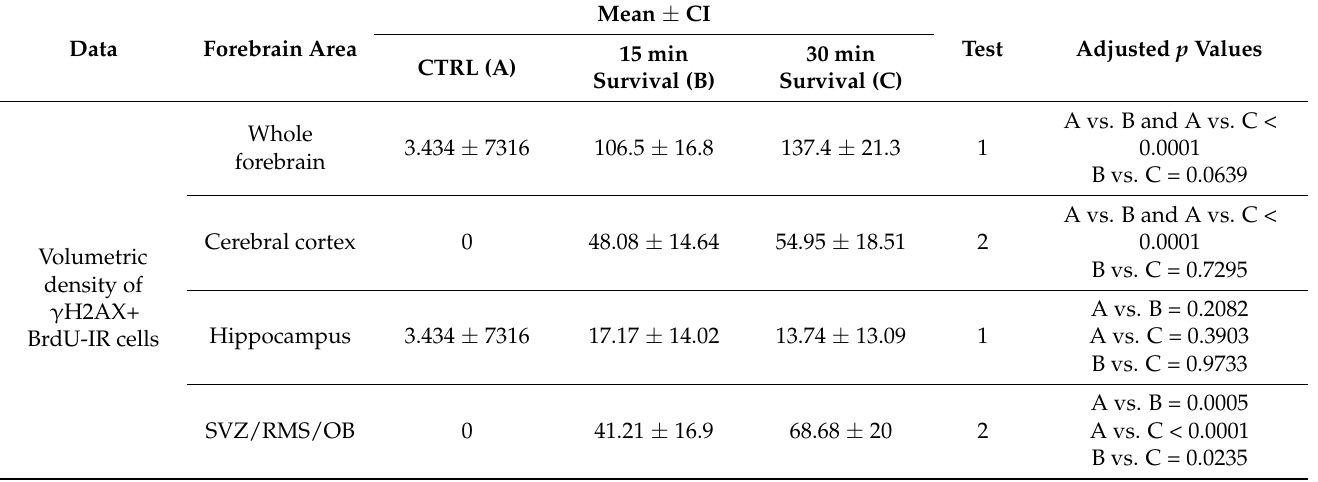
Table A7. Statistical analysis of volumetric densities and percentages of BrdU + pHH3 immunoreactive cells. Legend : 1 = Welch’s ANOVA and Dunnett’s T3 multiple comparison test; 2 = Ordinary one-way ANOVA and Tukey’s multiple comparisons test. See Figure 15 for